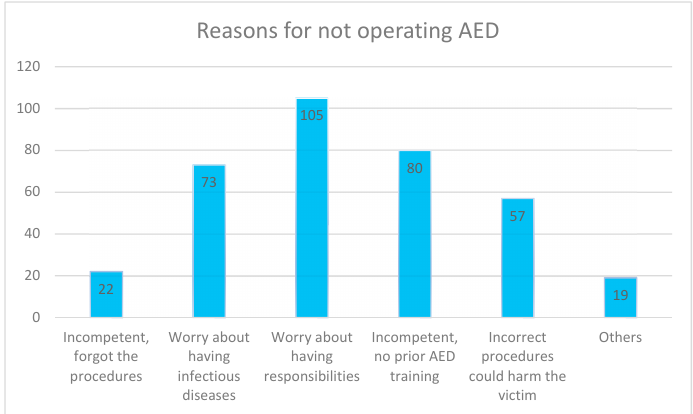
Figure 1. Reasons for not operating AED. * The respondents could choose more than one answer to this question. On whether the kind of victim would affect the bystander’s tendency or decision to operate an AED, more than half of the respondents, 53.30%, responded ‘Yes’. Among those 53.30%, the respondents would be most likely to offer help to a family member in the case of a sudden cardiac arrest, and less likely to offer assistance to a complete stranger, such as any pedestrians. Please refer to Figure 2 for details.